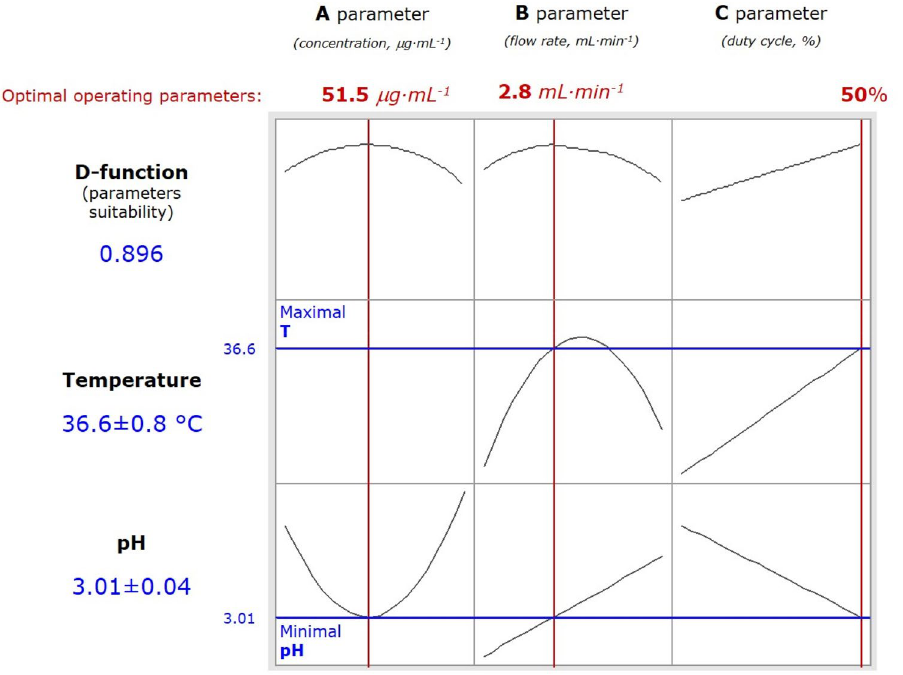
Figure 2. The effect of the pm-rf-APGD operating parameters on temperature (T, °C) and pH of the pm-rf- APGD-treated solution (according to the Box-Behnken matrix presented in Table S1).